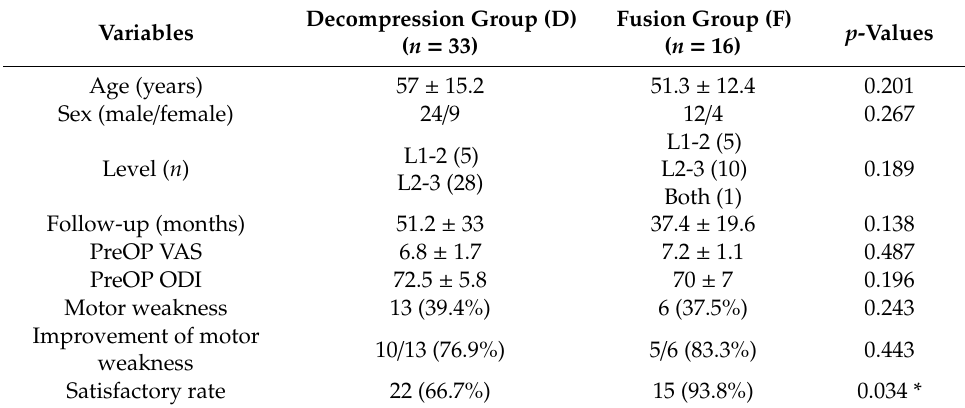
Table 1. Patient demographics and